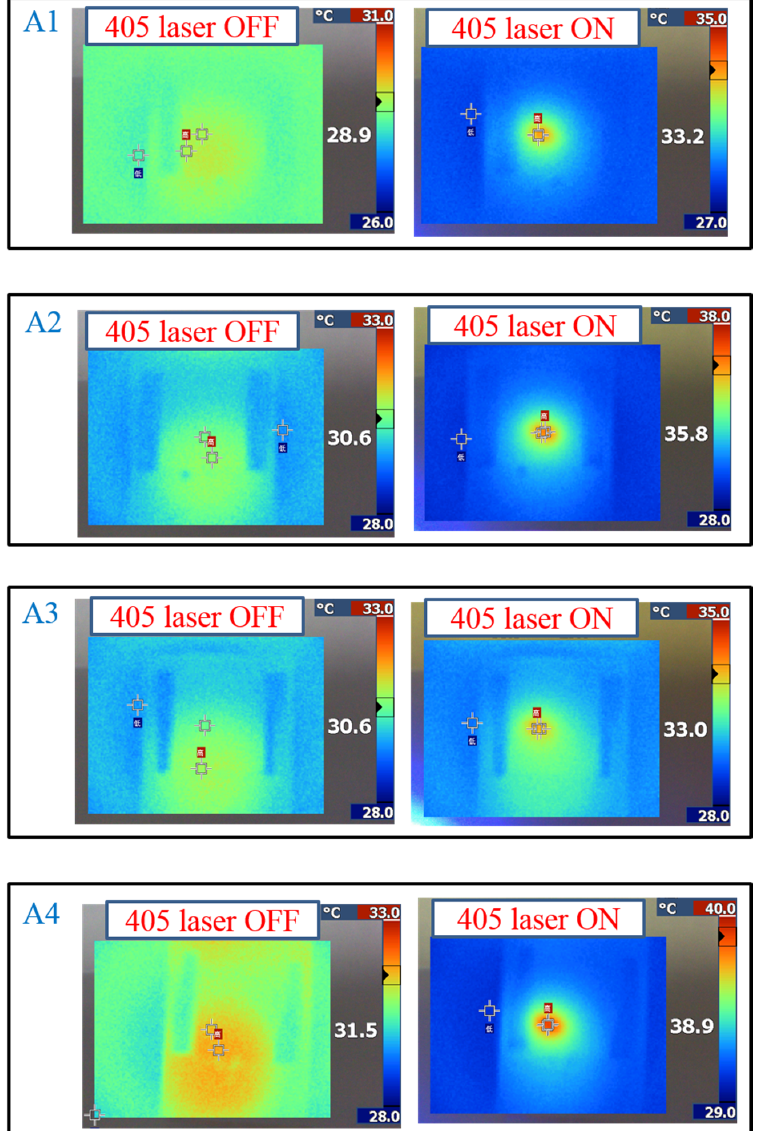
Figure 6. Temperature change of Azo-doped CLC samples under different conditions of laser exposure. The order of temperature change is A4 > A2 > A1 > A3. laser exposure. The order of temperature change is A4 > A2 > A1 >